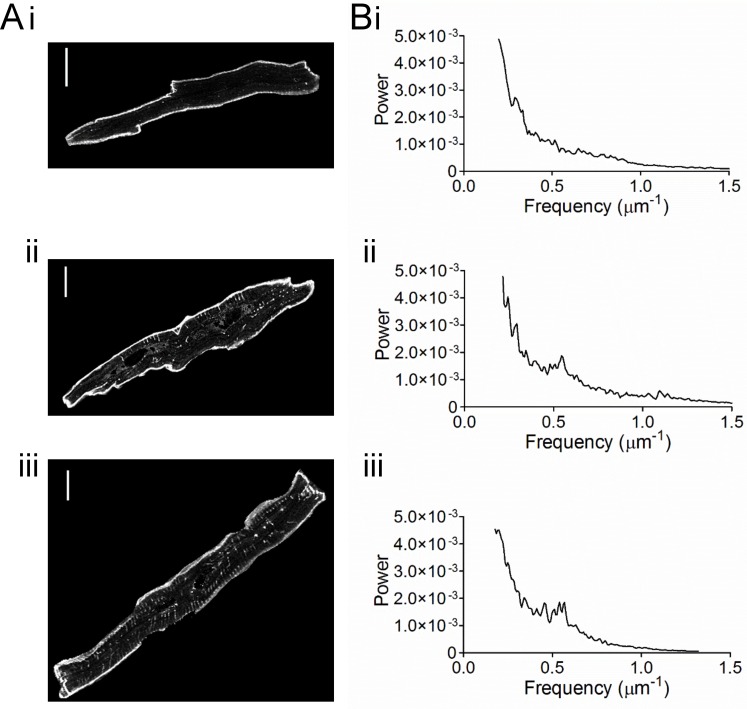
T-tubule density in atrial and ventricular cells from stained tissue sections.A) Selected representative examples of single (i) atrial cells without t-tubules, (ii) atrial cells with t-tubules and (iii) ventricular cells. Scale bars represent 12 μm. TTD and short axis diameter were, respectively, 1.8502 and 11.73 μm (i), 7.7678 and 22.14 μm (ii) and 7.7414 and 20.05 μm (iii). B) Corresponding power spectra for the cells shown in A. The peaks in Bii and Biii were at, respectively, 0.535 and 0.539 μm-1.